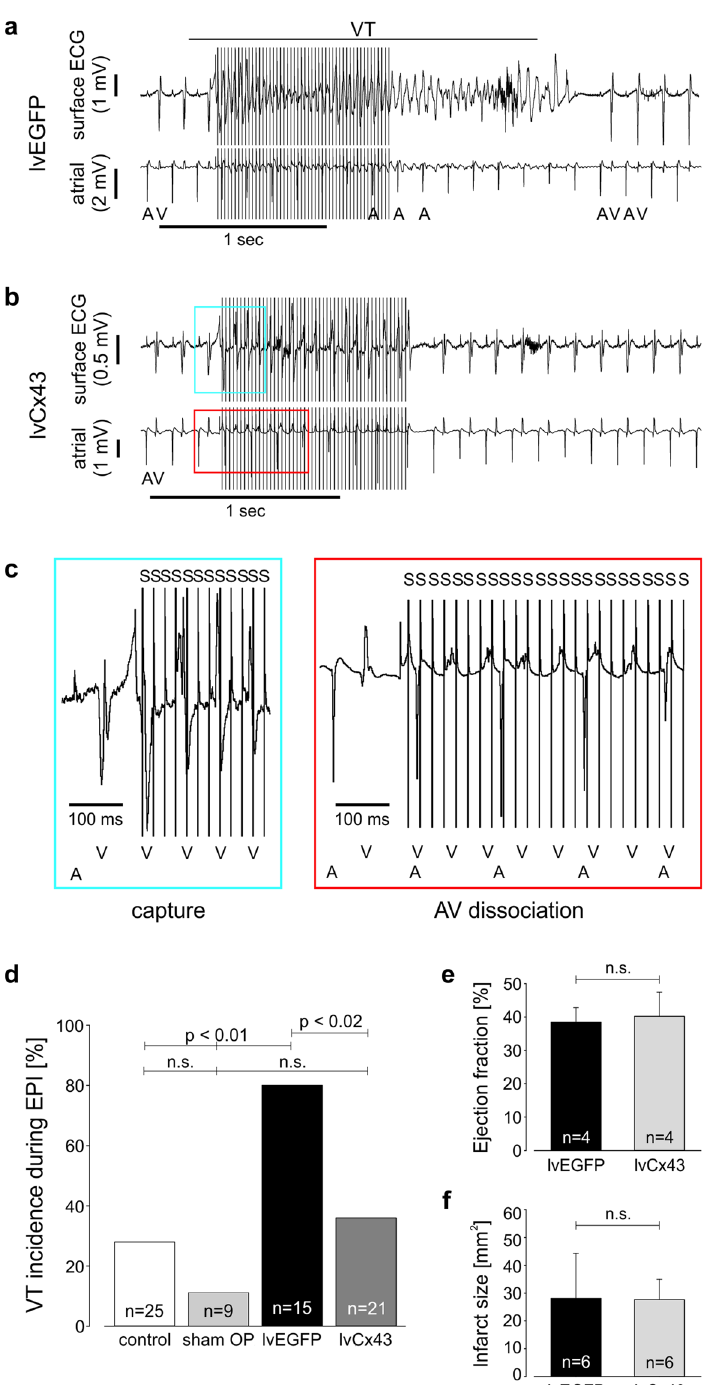
Figure 3. Injection of lvCx43 into the myocardial scar strongly lowers post-infarct VT incidence in vivo at 2 weeks after gene therapy ; myocardial remodeling and left ventricular function remain unaltered. ( a – c ) In vivo electrophysiological testing. ( a ) Burst stimulation induces self-limiting VT with typical atrio-ventricular dissociation (lower panel) in a representative lvEGFP injected mouse (upper panel). ( b ) No VT is evoked in a representative lvCx43 transduced mouse upon burst stimulation. (a,b) Top trace, surface ECG; bottom trace, atrial intracardiac lead. ( c ) Magnification of traces shown in (b) reveals appropriate stimulation during the stimulation train, but no VT is induced; due to the short refractory period of murine ventricular myocardium a 3:1 capture during burst stimulation (S1S1 10–50 ms) is achieved. (a–c) A, atrium; V, ventricle. ( d ) In vivo VT incidence after transduction with lvCx43 is significantly reduced compared to lvEGFP injected control hearts (p < 0.02). ( e , f ) lvCx43 and lvEGFP injected hearts display very similar left ventricular function ( e ) and infarct size ( f